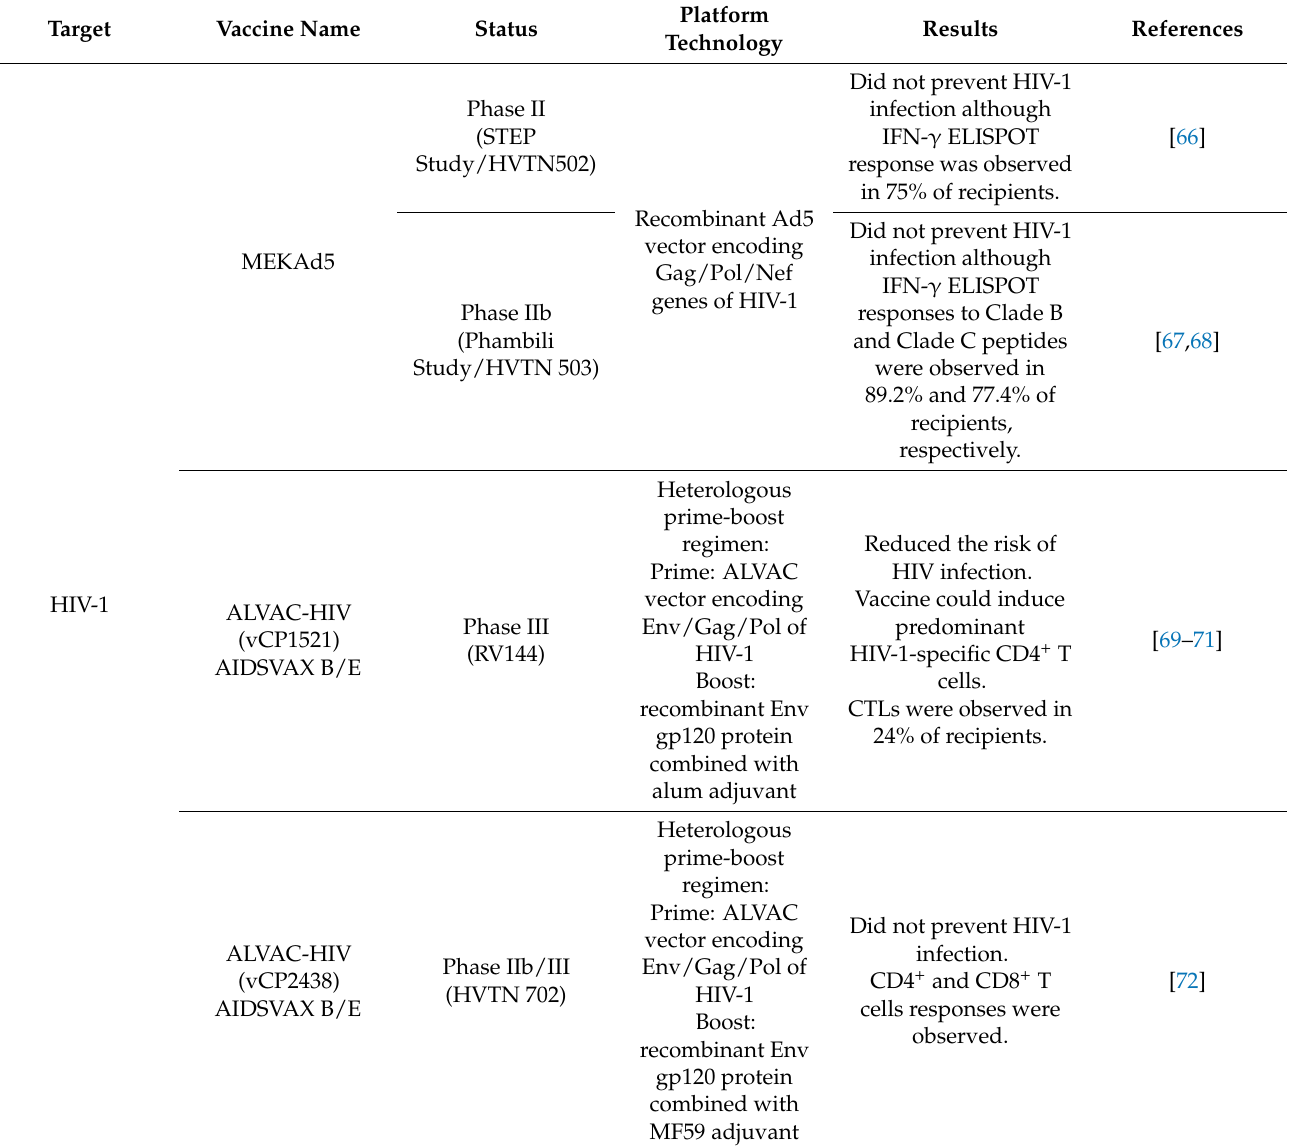
Table 1. List of results of representative viral vector vaccines and T cell-mediated